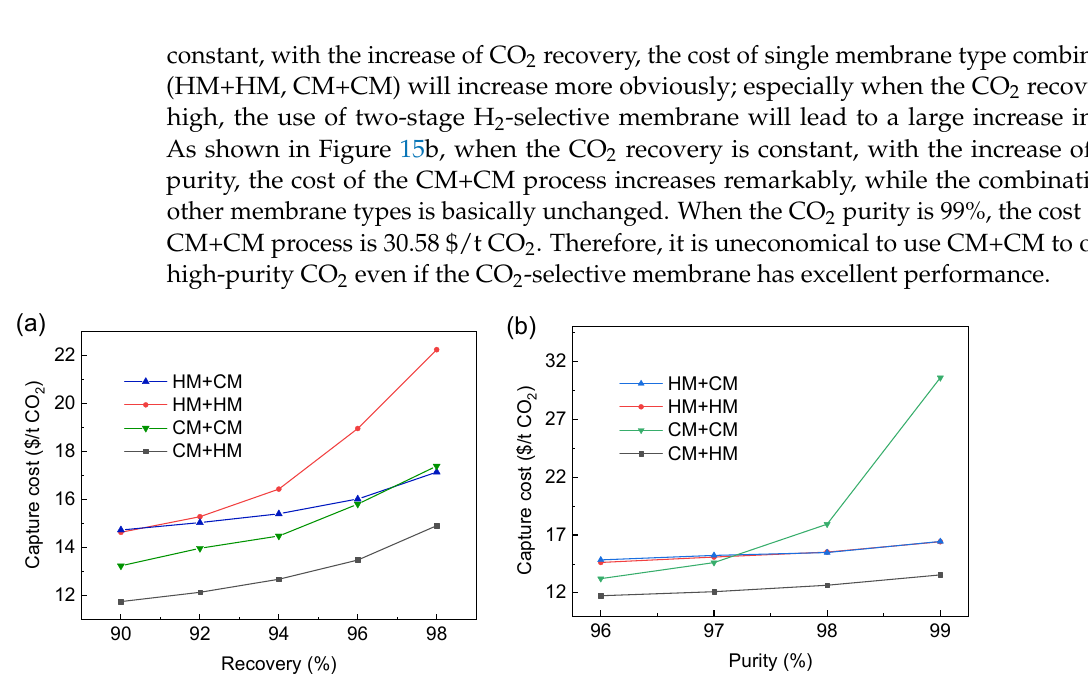
Figure 15. Cost of different membrane combination processes ( a ) vary with CO 2 recovery when CO 2 purity is 96%; ( b ) vary with CO 2 purity when CO 2 recovery is 90%.